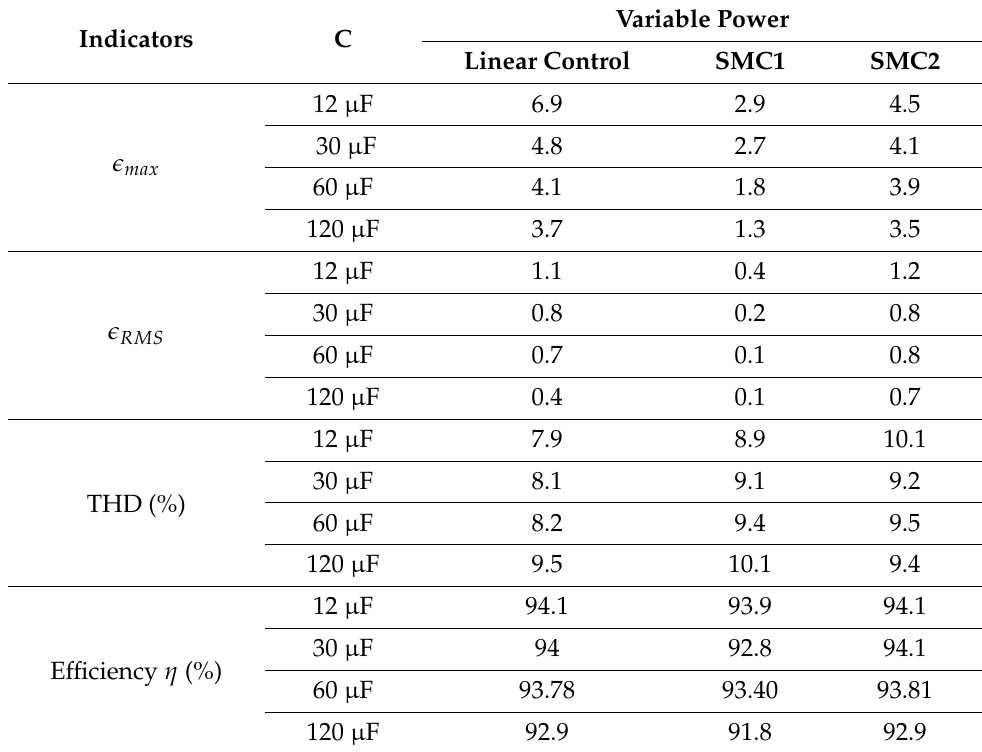
Table 6. Comparison of the errors, (cid:101) max and (cid:101) RMS , and the THD line current obtained by the three algorithms in a real experiment under a real